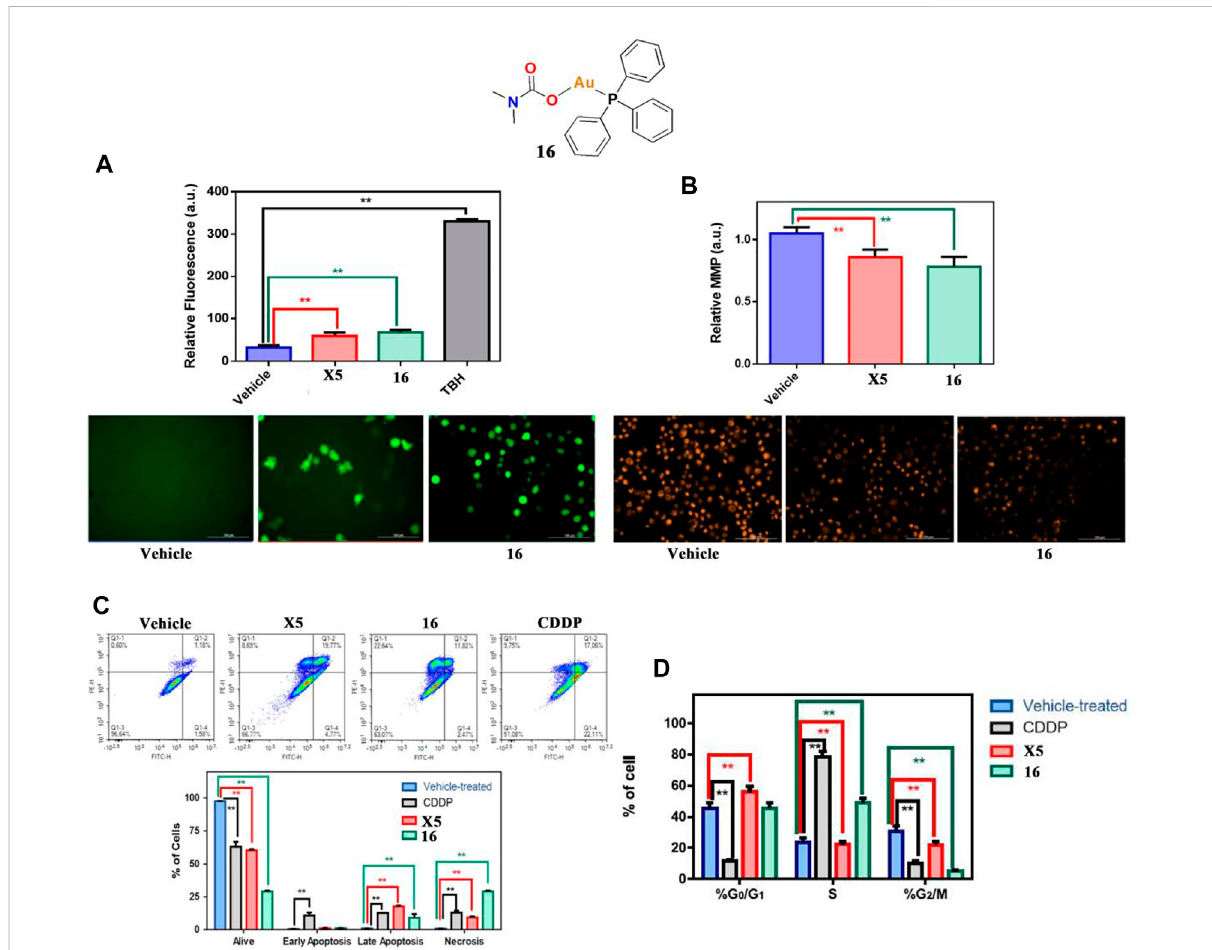
FIGURE 9 (A) ROS production by H 2 DCFDA inA549 cells after treatment with complex 16 atIC 50 valuesfor 4 h. (B) Mitochondrial membranepotential by TMRM in A549 cells after treatment with complex 16 at IC 50 values for 1 h. (C) Flow cytometer analysis of A549 cells treated with complex 16 at IC